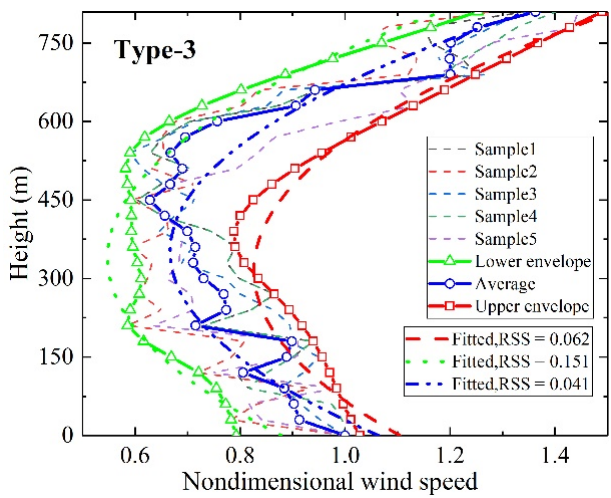
Figure 12. Wind speed profile of Type-3.